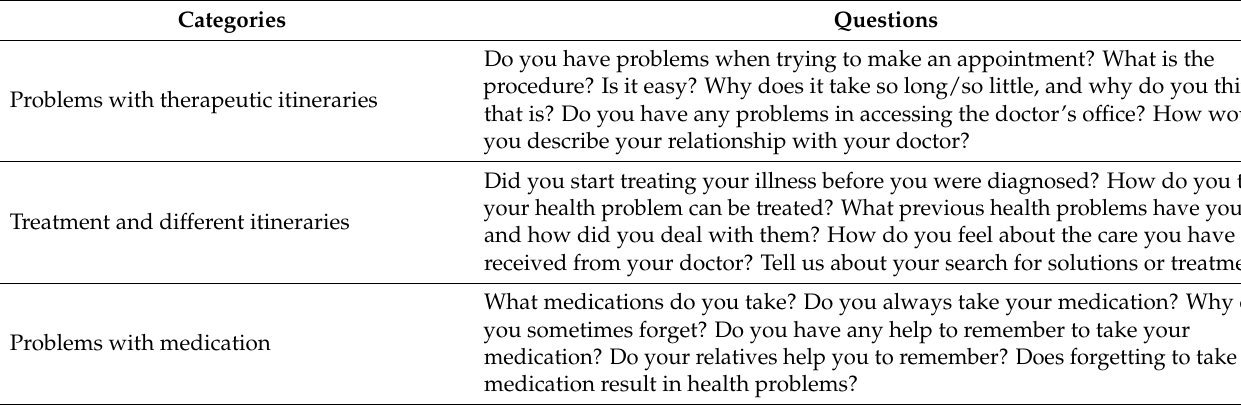
Table 2. Example of categories and questions for the